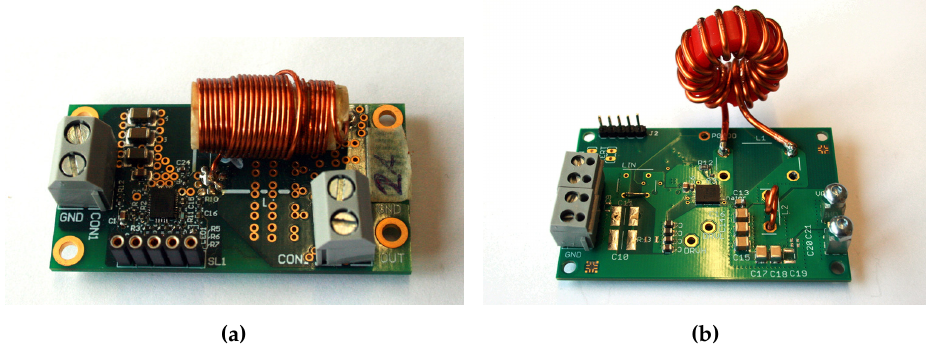
Figure 16. Power boards used for powering ( a ) front-end boards and ( b ) detector ASICs